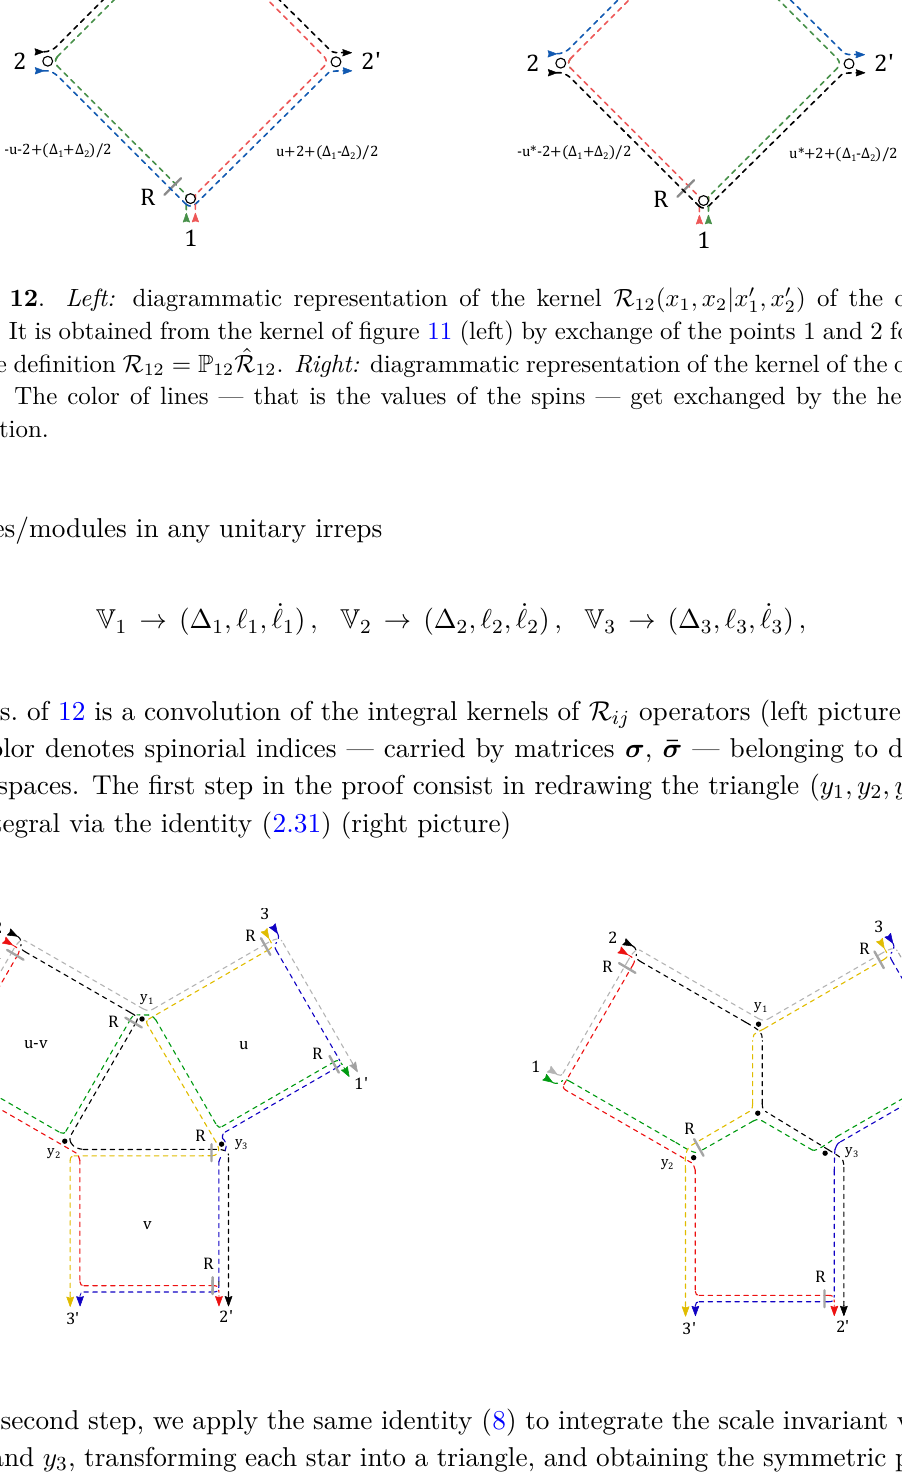
) of the operator , x 0 1 2